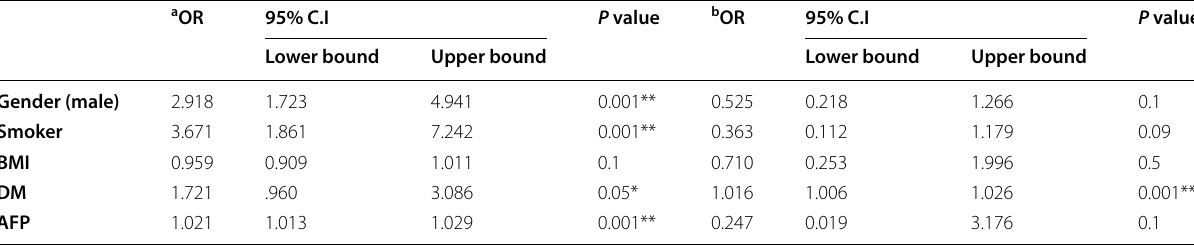
Table 5 Univariate and multivariate regression analysis of the risk factors of